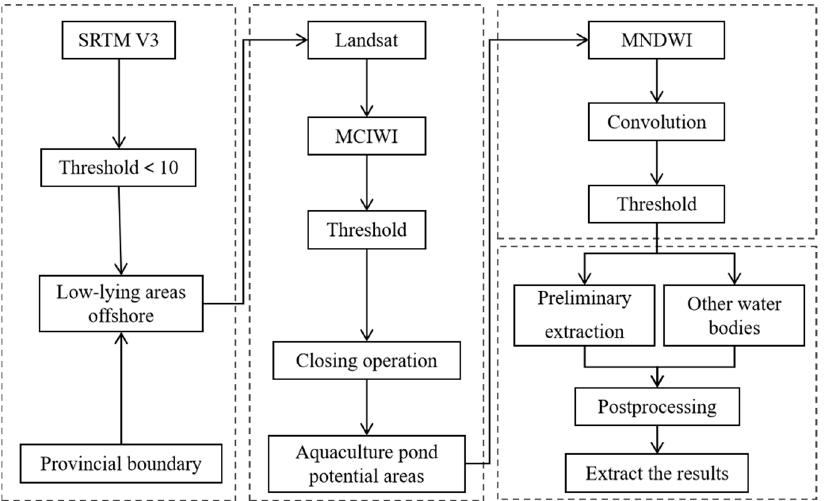
Figure 3. Flowchart of the aquaculture pond region extraction procedure ( MCIWI : Modified Com- bined Index for Water Body Identification; MNDWI : Modified Normalized Difference Water Index).